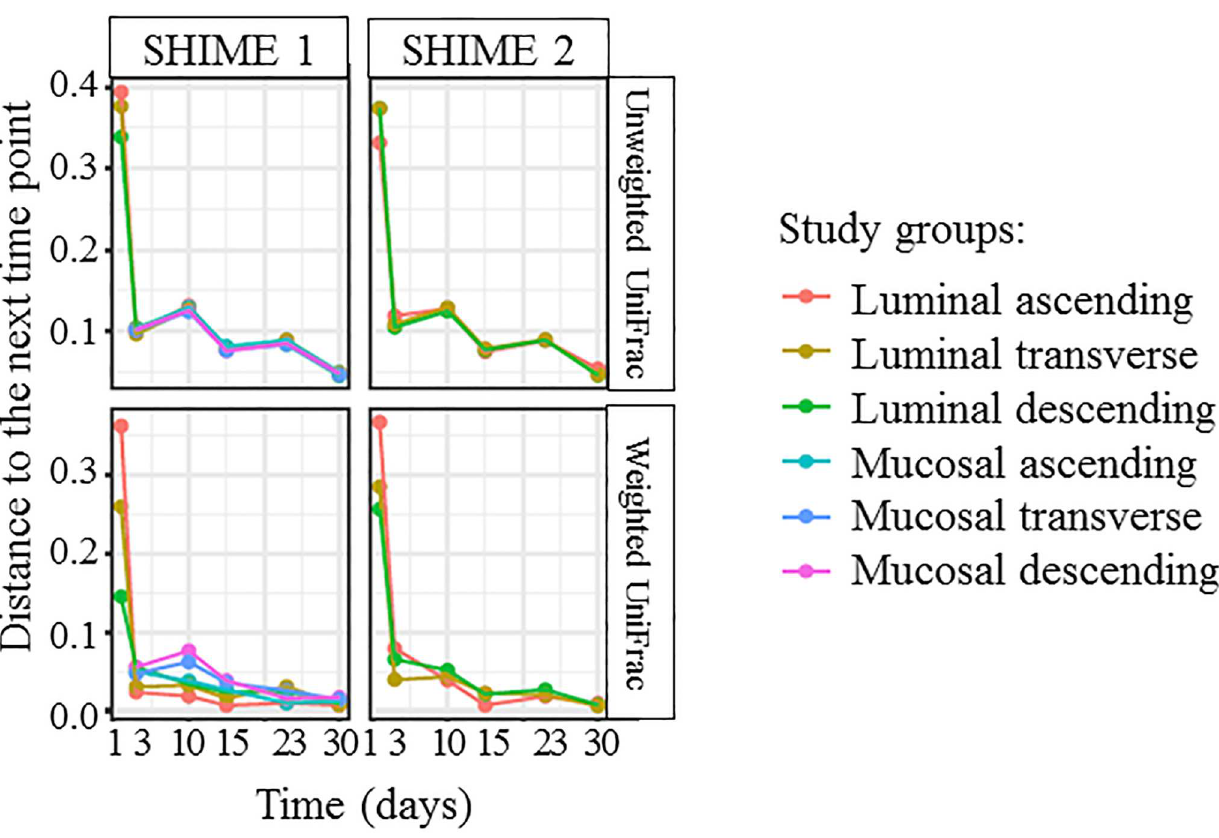
Fig 2. Comparison of unweighted and weighted UniFrac measurements from each time point to the next for the luminal and mucosal phases of each colon region over time.